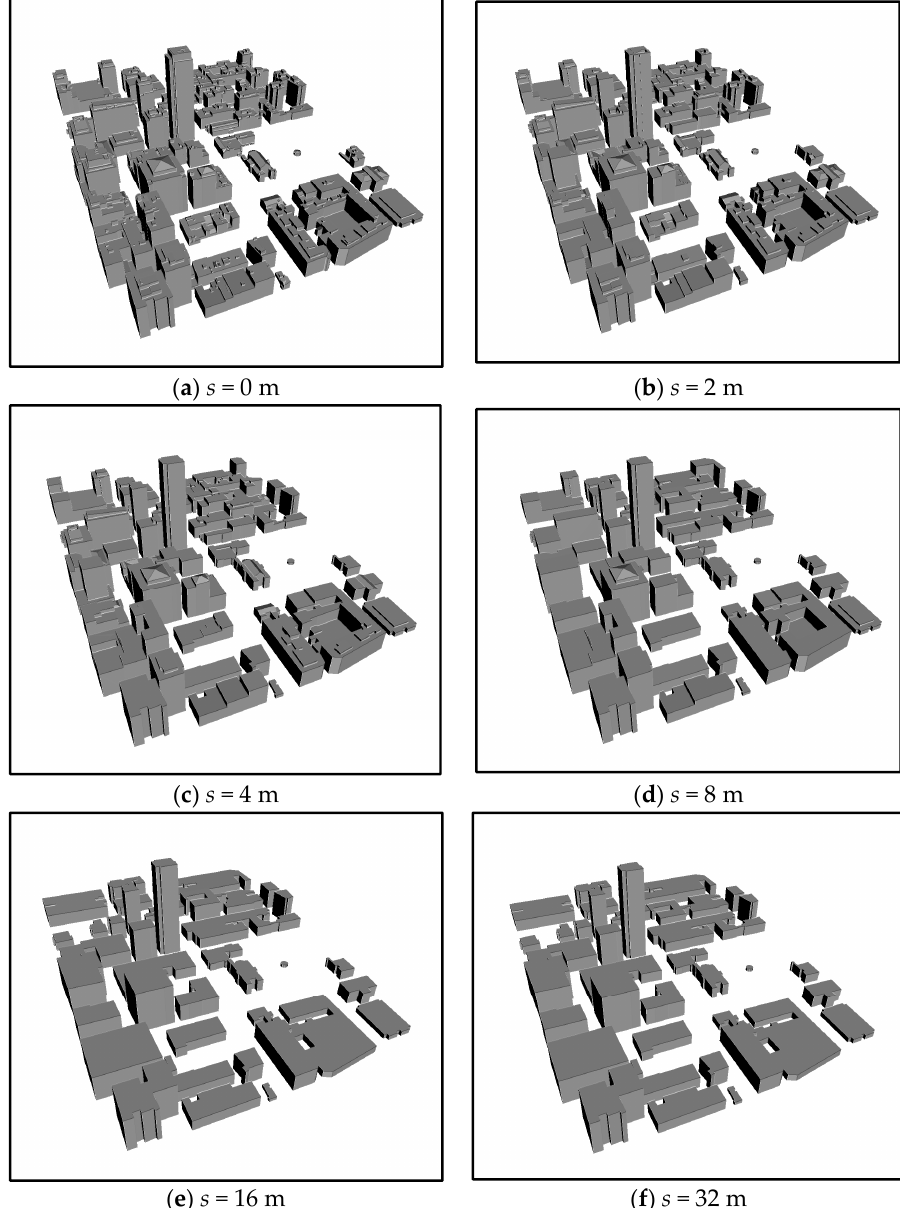
Figure 14. Results of reconstructing the building LoDs in the entire scene. The roof structures are changed from complicated to simple with the increasing of the scale. Because different buildings have different levels, the model of the maximum scale is utilized at a larger scale. ( a ) The building models within the scale of 0 m. ( b ) The building models within the scale of 2 m. ( c ) The building models within the scale of 4 m. ( d ) The building models within the scale of 8 m. ( e ) The building models within the scale of 16 m. ( f ) The building models within the scale of 32 m.